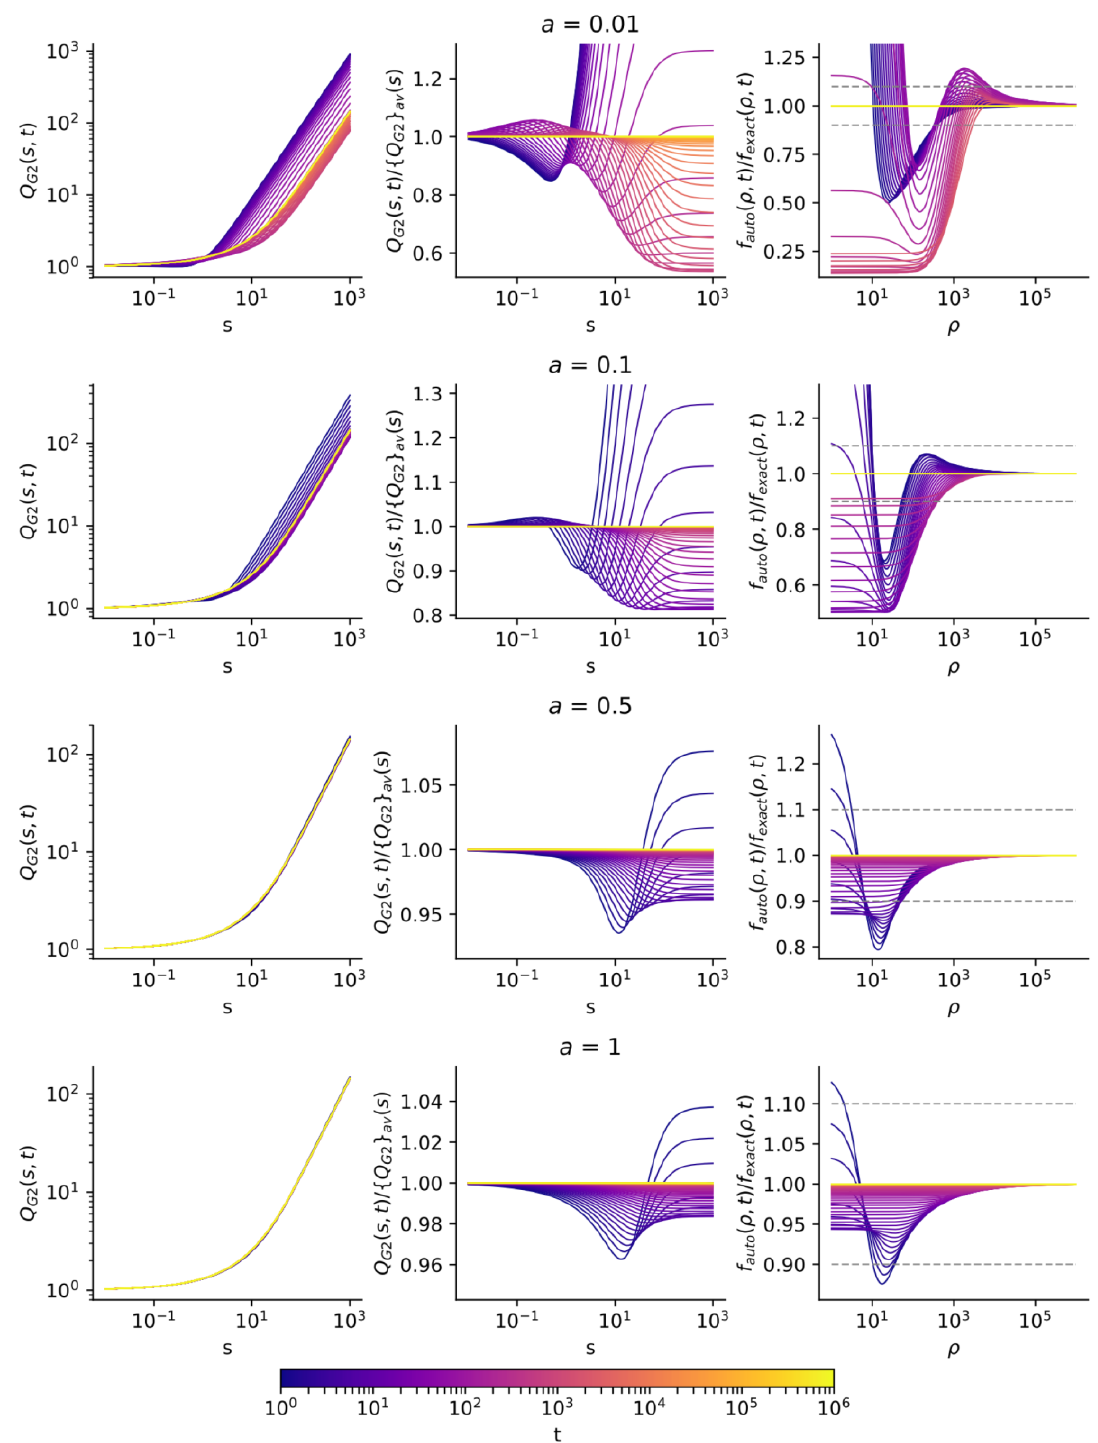
Figure 2. The result of accuracy analysis of automodel solution for various values of the Voigt parameter and the propagation front ρ = ρ fr taken in the form of Equation (24), for different values of t in the range from t min = 30 to t max = 10 6 : ( left ) Functions Q G2 ( s , t ) (29); ( center ) normalized functions Q G2 ( s , t )/{ Q G2 } av ( s ), where subscript av denotes averaging over time from t min = 30 to t max = 10 8 ; and ( right ) relative errors of the automodel solution f auto ( ρ , t )/ f exact ( ρ , t ).